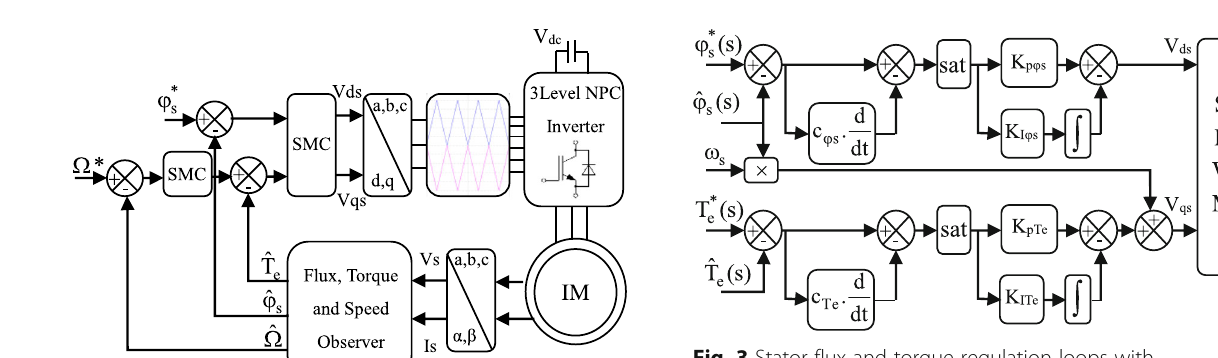
Fig. 3 Stator flux and torque regulation loops with the